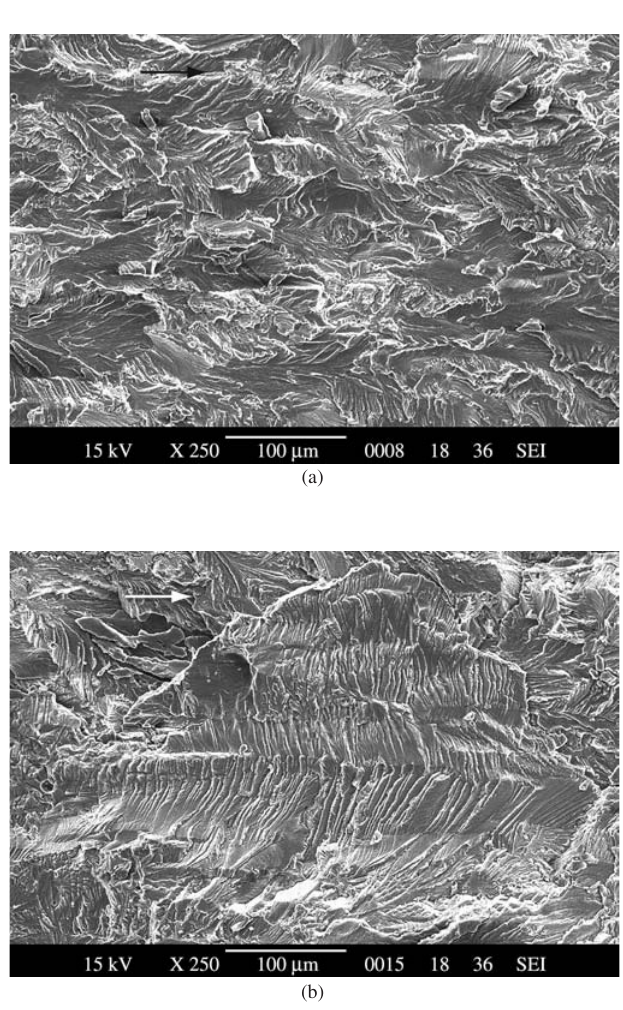
Figure 9. SEM fractography of Al 2024 alloy of a) low ∆ K region; and b) high ∆ K region. 250X. Arrow indicates the direction of crack propagation.